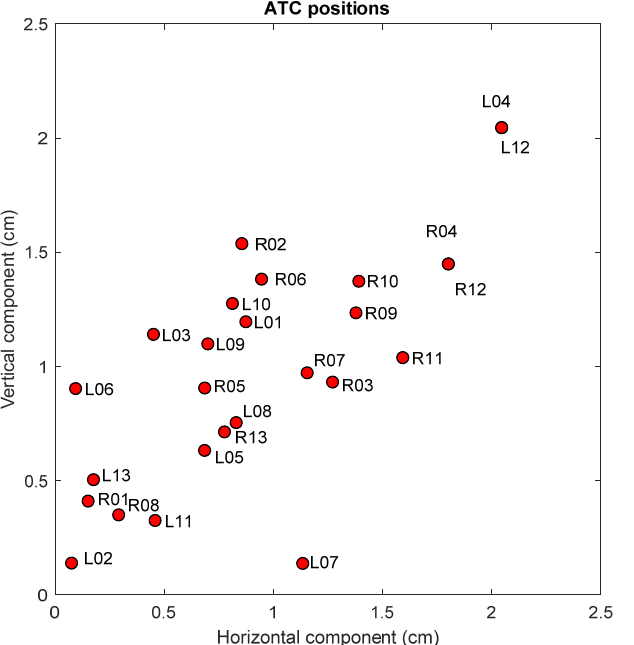
Figure 4. Horizontal and vertical components of the resulting ATC positions for each participant.